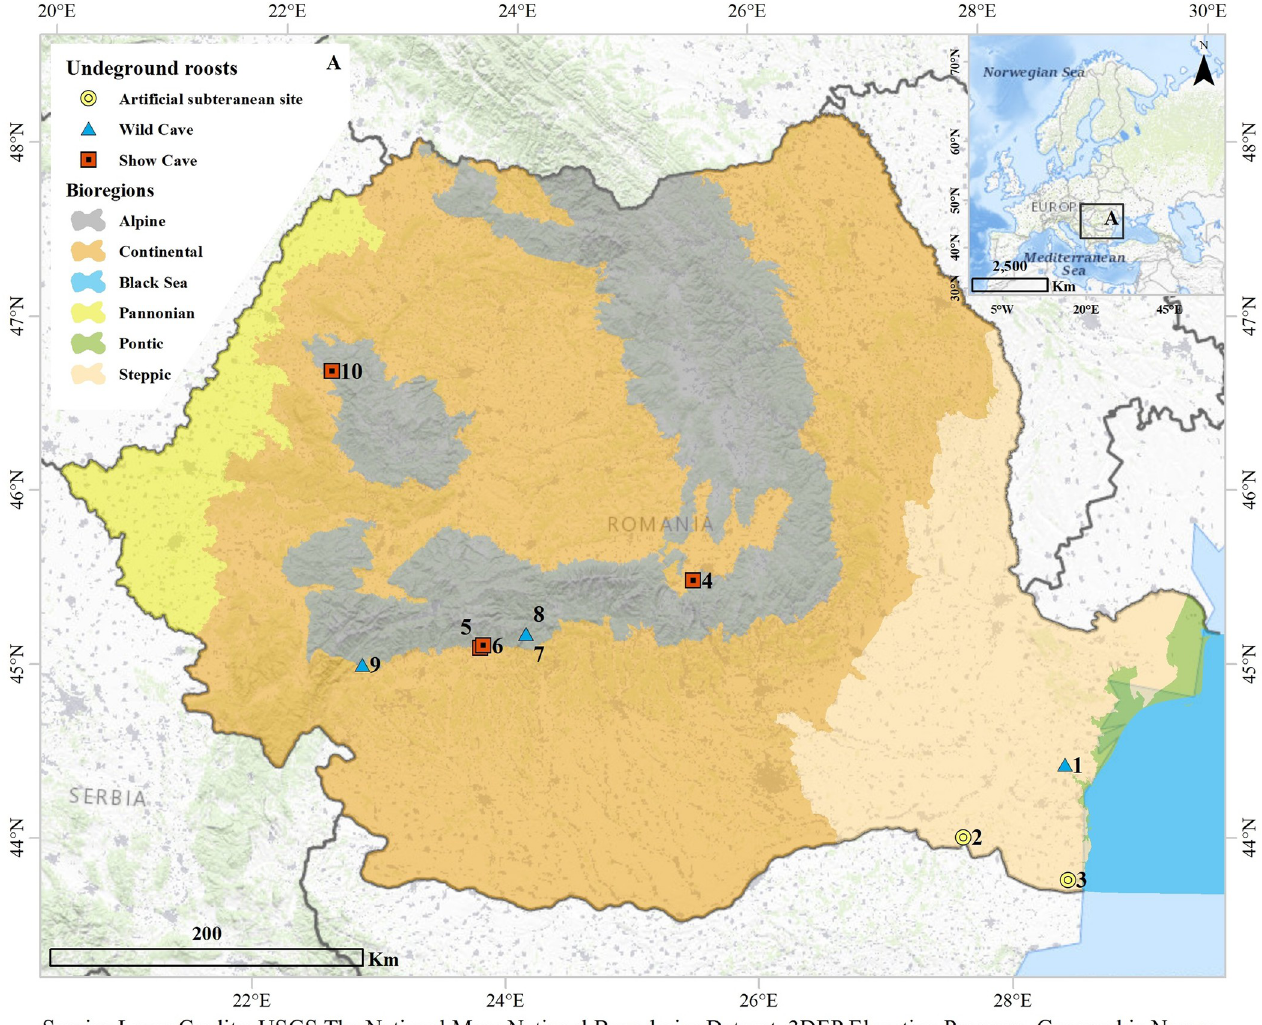
Fig 1. Locations of surveyed SEs, classified by type and biogeographical region [55]. 1—Gura Dobrogei cave, 2—Canaraua tunnel, 3—Hagieni tunnel, 4— Valea Cet ăţ ii cave, 5—Muierilor cave, 6—Polovragi cave, 7—Stogu cave, 8—Lacul Verde cave, 9—Clo ş ani cave, 10—Meziad